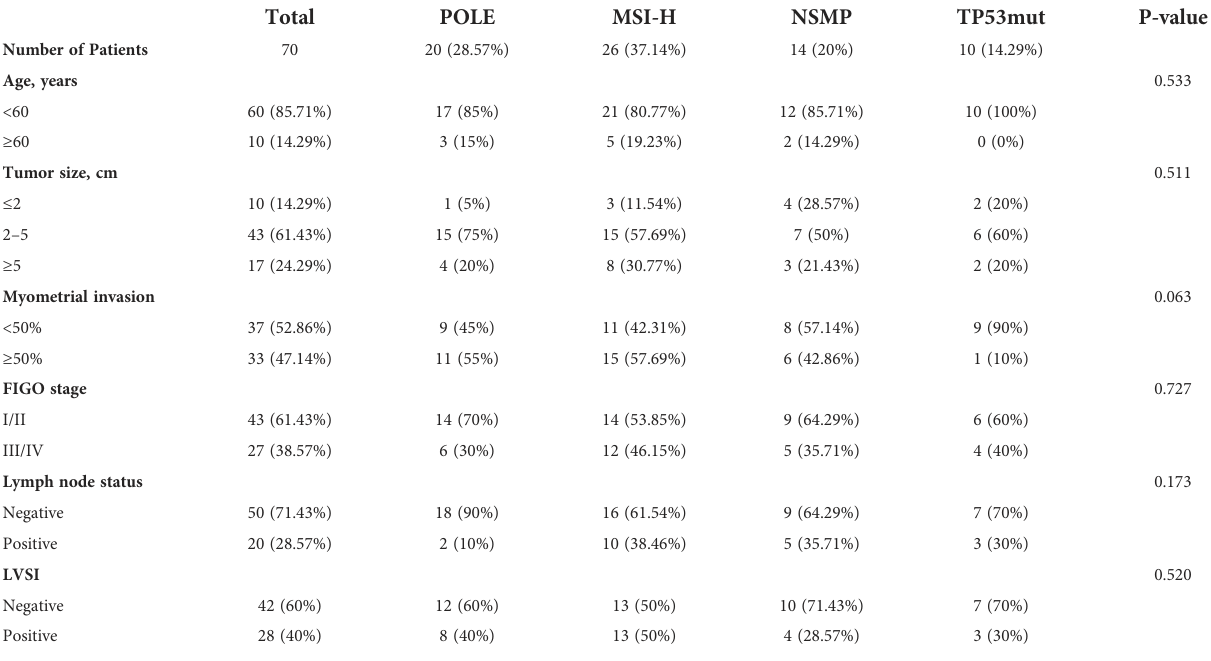
TABLE 1 Univariable associations of molecular subtypes with clinicopathological